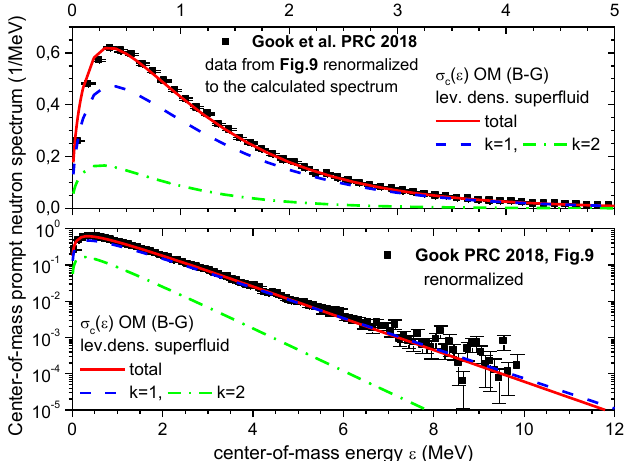
Fig.5 : LA model calculation of the centre-of-mass spectrum for the first emitted neutron (dashed blue line), the second emitted neutron (green dash-dotted line) and the total centre-of-mass spectrum (solid red line) in comparison with the experimental data of Göök et al.[4] (black